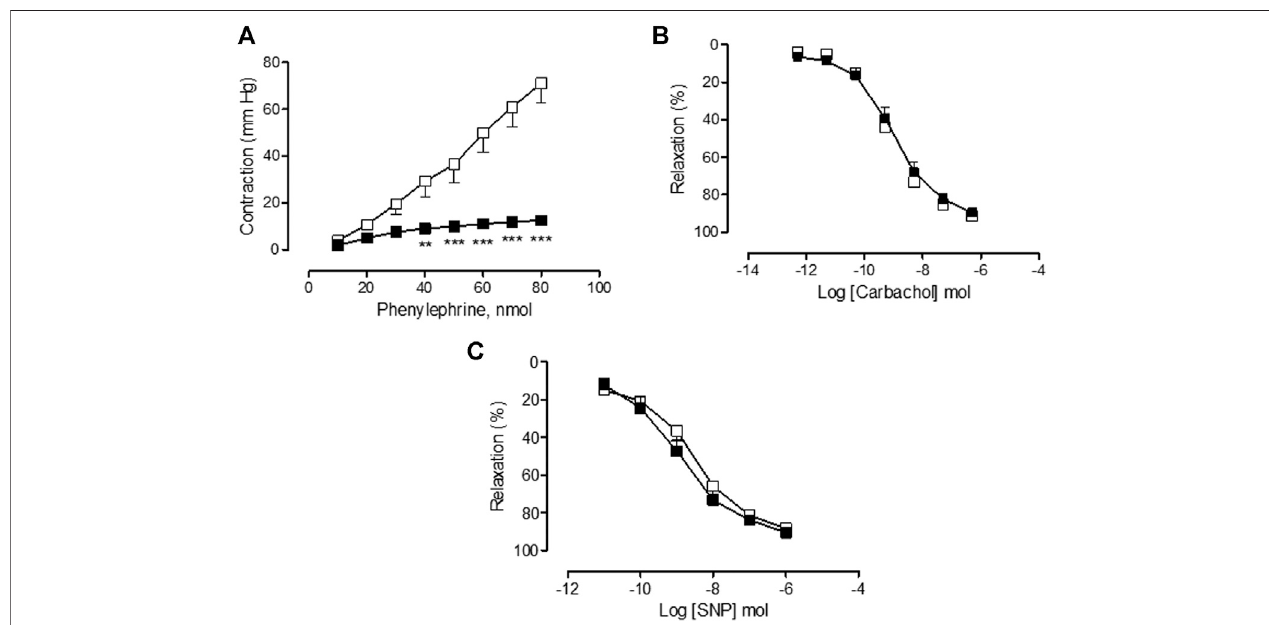
FIGURE 5 | (A) Concentration-response curve of phenylephrine (10 – 80 nmol), (B) concentration-response curve of carbachol (3 · 10 − 10 mol – 3 · 10 − 5 mol), and (C) concentration-response curve of sodium nitroprusside (SNP) (3 · 10 − 11 mol – 3 · 10 − 6 mol) in perfused mesenteric bed from animals chronically treated with saline (saline treatment, white squares) or vincristine (vincristine treatment, black squares). Values are expressed as mean ± SEM, n (cid:2) 9 – 13 preparations per experimental group. A two-way ANOVA followed by the Bonferroni test was used for statistical analysis (*** p < 0.001, ** p < 0.01, vincristine treatment vs. saline treatment).